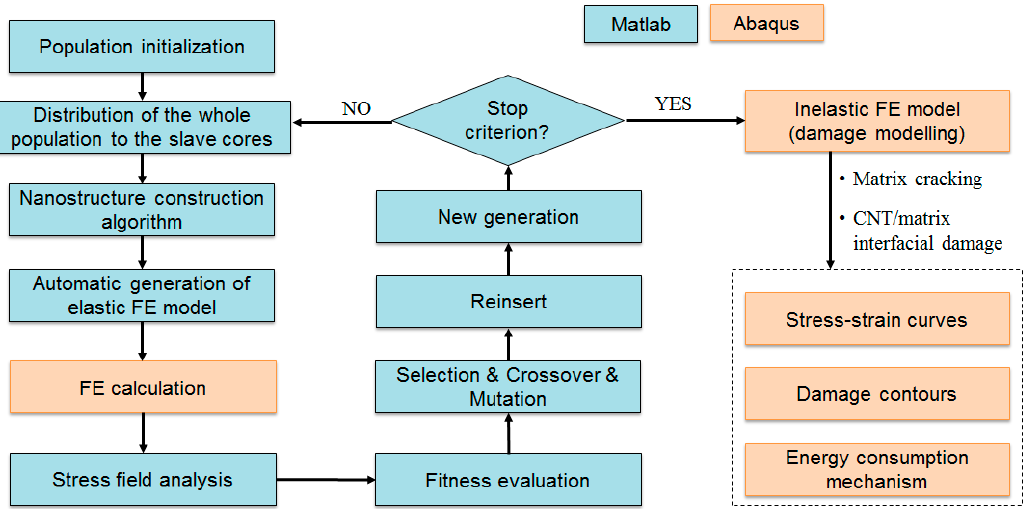
Figure 2. Flowchart of the optimization tool with generic algorithm (GA) and finite element method (FEM) combined. FE; finite element.